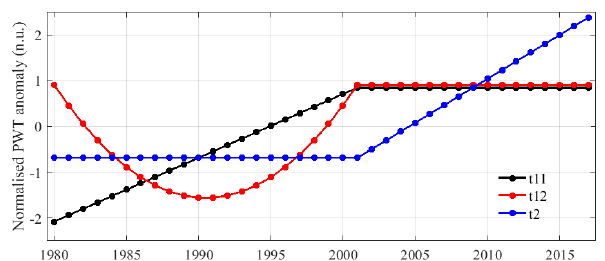
Figure 7. Anomalies of the linear functions before and after 2001 ( t 11 and t 2, respectively) and parabolic function ( t 12) that corre- spond to the PWT proxy (see Eqs. 2 to 5). Each proxy anomaly is normalized by the corresponding standard